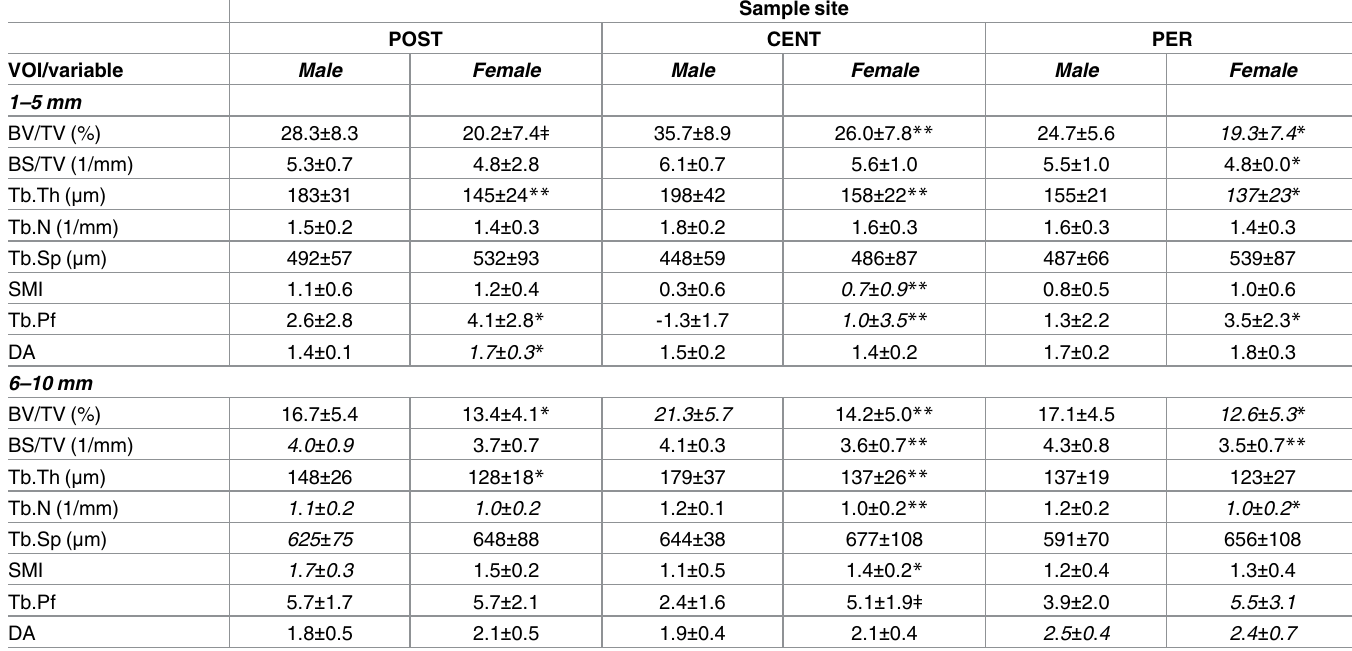
Table 3. Subchondral trabecularbone (STB) architectural variables by sample site and gender and depth (1–5 and 6–10 mm below the